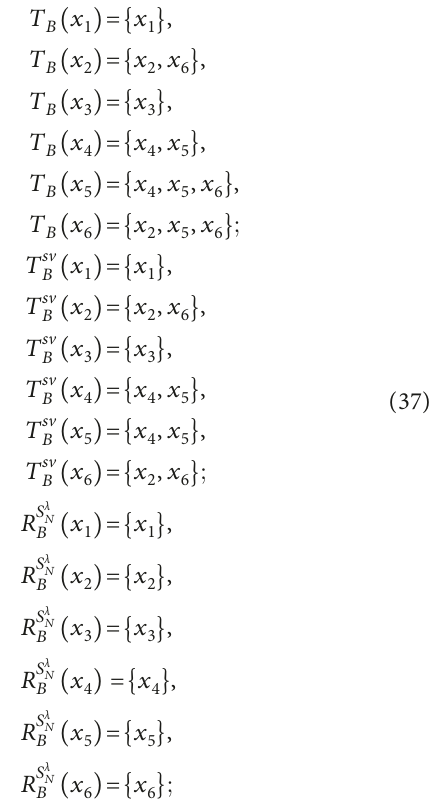
Table 14: The incomplete information system about car dataset.